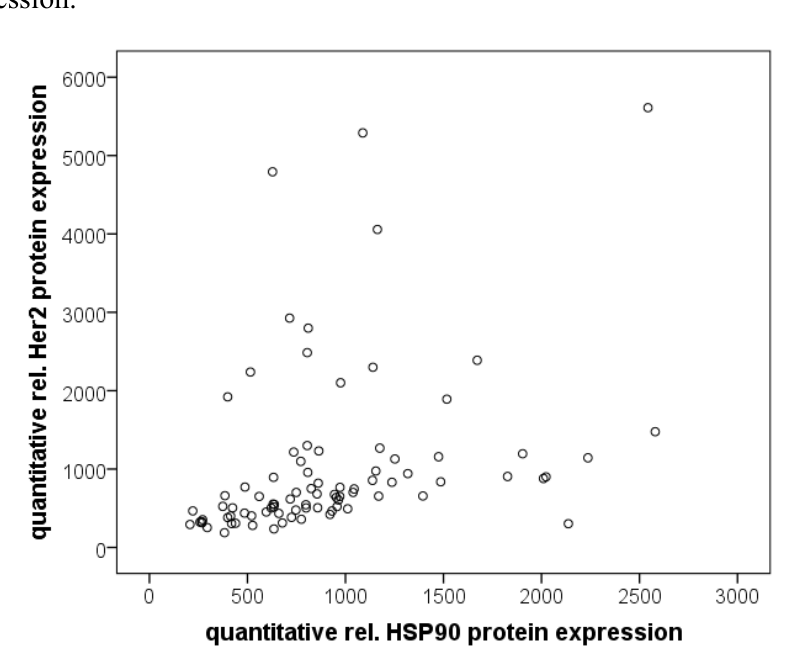
Figure 2. Scatterplot with RPPA data for quantitative relative Her2 expression and HSP90